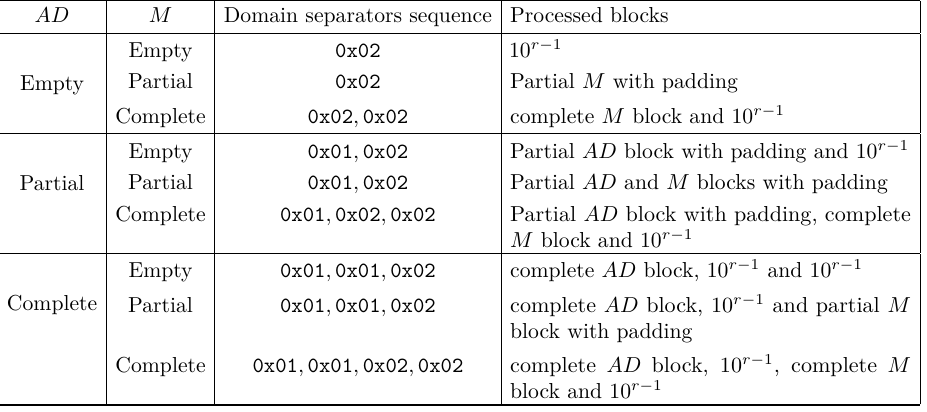
Table 7: Domain separators for different processed blocks (current last block) where r = 64 AD